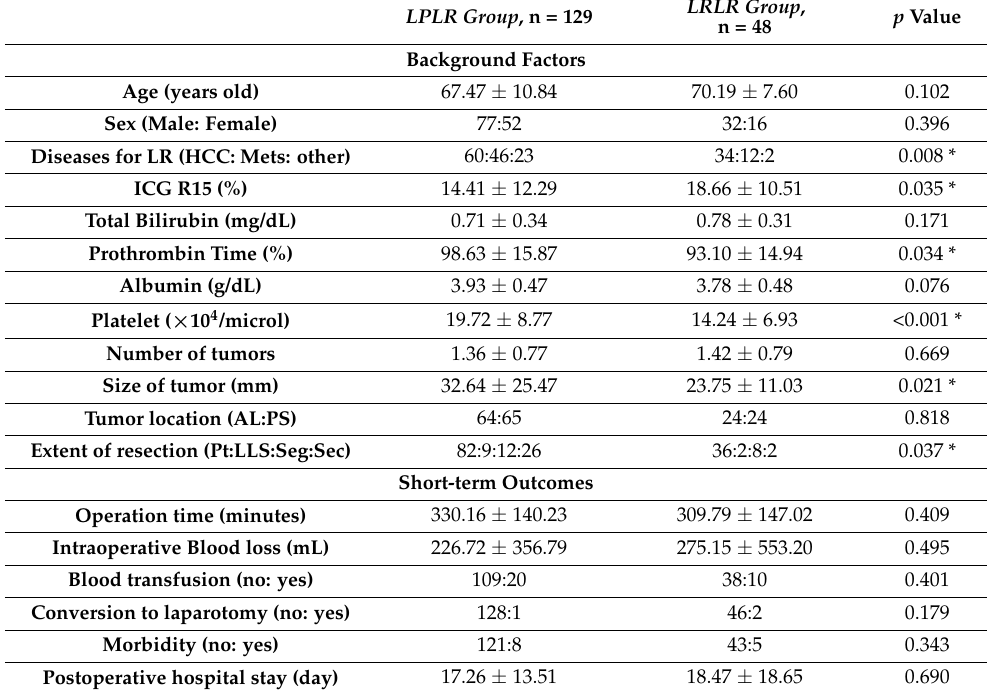
Figure 2. Simulation for fourth laparoscopic liver resection of three tumors in segment 4. Three tu- mors (1,2, and 3) all developed in segment 4 after segment 3 segmentectomy (1st laparoscopic liver resection (LLR)), partial resection of segments 5 – 6 (2nd LLR) and partial resection of segments 1 – 7 (3rd LLR). Tumor 1 was in caudal area near the border of segments 4 – 3. Tumor 2 was in cranial surface area. Tumor 3 was in cranial dorsal area. Left: preoperative CT simulation from CT recon- struction. The area encircled with yellow line, which is the portal area of Glissonian pedicles 4a and 4b (yellow ruptured lines) and includes three tumors to be resected. Glissonian pedicle 4c (red rup- tured line) is planned to be exposed and preserved on the bottom surface of transection. The areas encircled by white ruptured lines show the adhesion from previous surgeries. With the planned approach route shown with red arrows, the area encircled with green line is the planned surgical